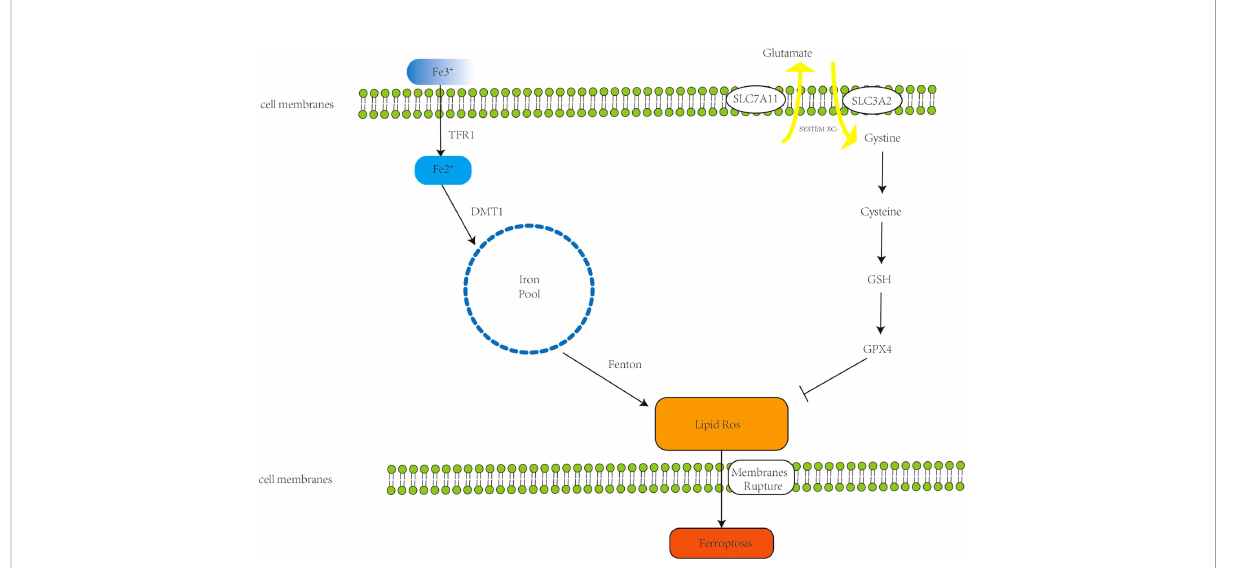
FIGURE 1 The primary mechanism of ferroptosis. Extracellular Fe 3+ binds to transferrin receptor 1 (Tfr1) to form Fe 2+ ; Fe 2+ forms an unstable iron pool in the presence of divalent metal transporter 1 (DMT1). The Fenton reaction generates lipid reactive oxygen species (ROS), which cause cell membrane breakdown and, in the end, ferroptosis. The Xc- system, comprised of Recombinant Solute Carrier Family 3 (SLC7A11) and Recombinant Solute Carrier Family 7, Member 11 (SLC3A2), transports internal glutamate to the cell ’ s surface while also importing cystine, which initiates glutathione synthesis. Glutathione peroxidase 4 (GPX4) is a glutathione substrate that inhibits ROS and